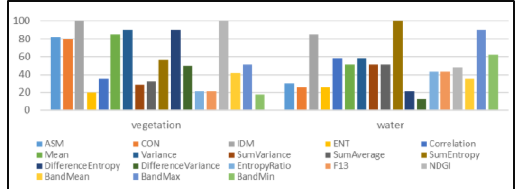
Fig 5. Feature contribution indices